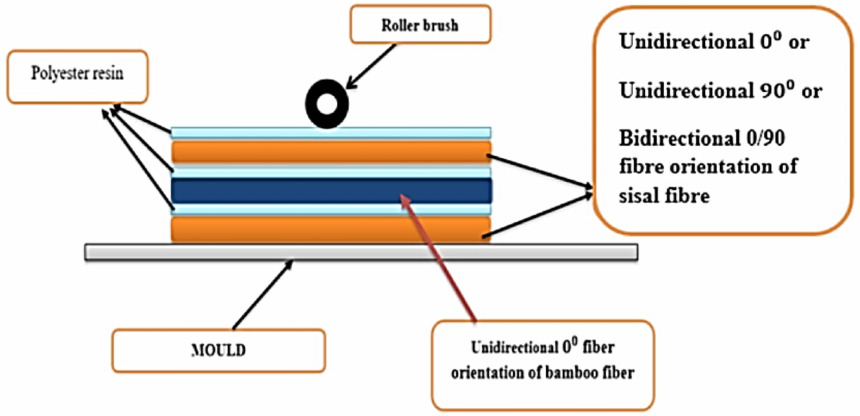
Figure 15. Fabrication of composite with varied orientations of sisal fiber [91]. Reprinted with permission,